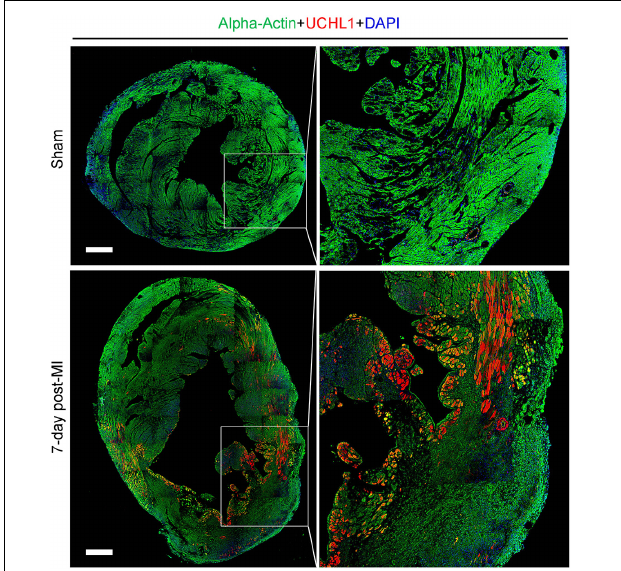
FIGURE 2 | Post-MI myocardial upregulation of Uchl1 occurred primarily in the cardiomyocytes of the border zone in mice. Shown are representative micrographs of immunofluorescence staining for Uchl1 (red) and sarcomeric α -actin (green) in mouse hearts 7 days after LAD ligation or sham surgery. The sections were counter-stained with DAPI to visualize nuclear DNA (blue). The heart scale bar, 500 µ